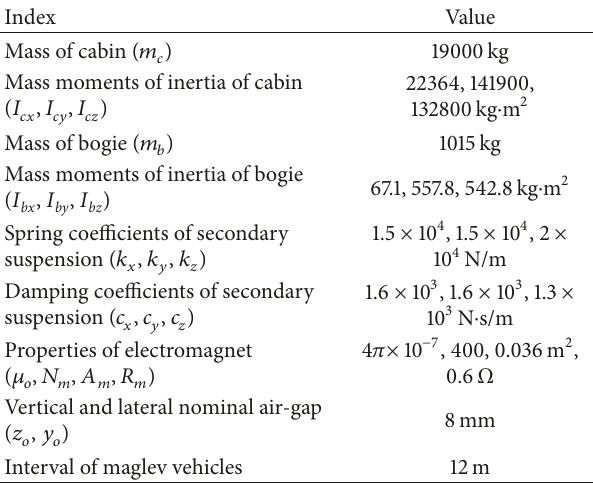
Table 2: Material properties of the UTM vehicle